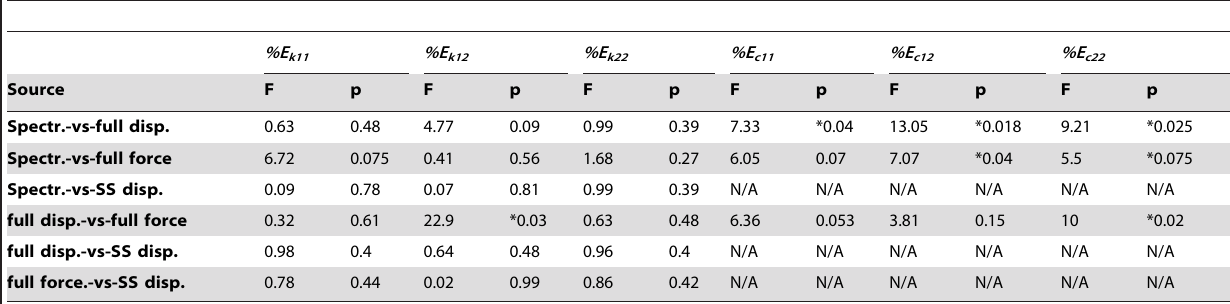
Table 4. Pairwise repeated measures ANOVA between estimation methods with stiffness and damping time-profiles as random factors along the interval 2.6–3.175 s.